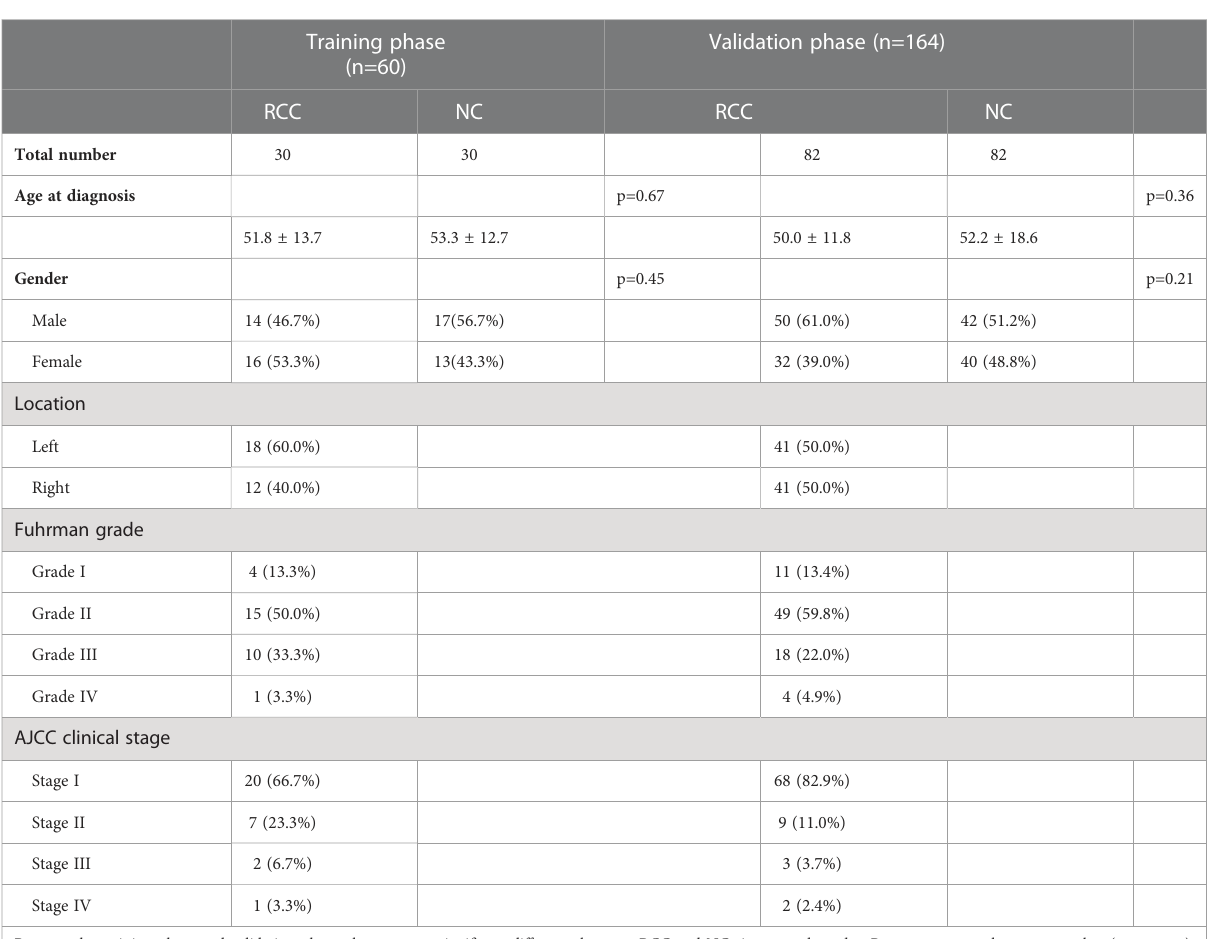
TABLE 1 Demographic and clinical manifestation of 224 participants (RCC and